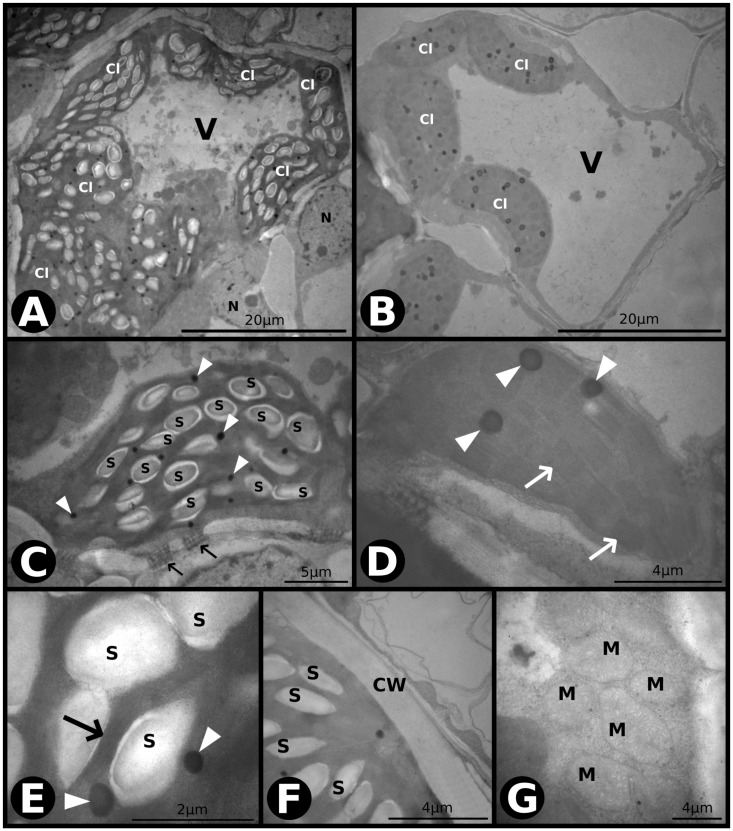
Transmission electron microscopy (TEM) photomicrographs of leaves of P. maximum under ambient [CO2] and ambient temperature (aCaT).(A) Overview of a bundle sheath cell (BSC). Cl–chloroplast, V–vacuole. N–nucleus. (B) Overview of a mesophyll cell (MC). Cl–chloroplast, V–vacuole. (C) A chloroplast of a BSC with plastoglobuli (indicated by arrowheads) and starch grains. Arrows indicate plasmodesmata between the BSC and MC. S–starch. (D) A chloroplast of a MC with plastoglobuli (indicated by arrowheads) and thylakoid membranes (indicated by arrows). (E) A chloroplast of a BSC showing details of thylakoid membranes (indicated by arrow) and plastoglobuli (indicated by arrowheads). S–starch. (F) The cell wall between the BSC and MC. S–starch, CW–cell wall. (G) Group of mitochondria of a BSC. M–mitochondria.